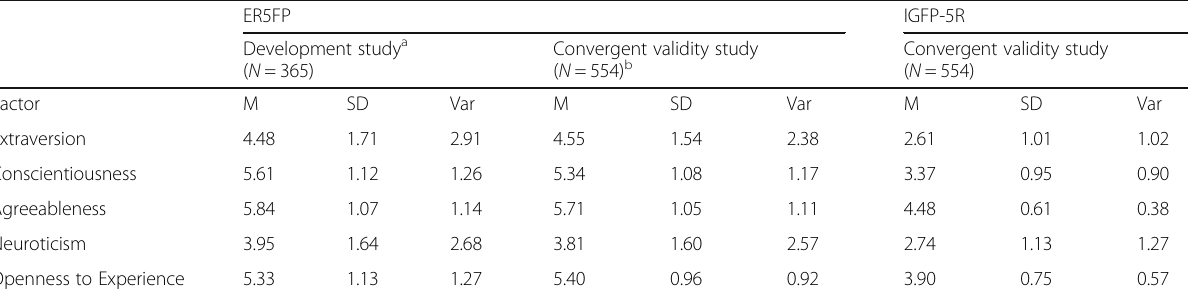
Table 5 Statistics of the factor scores of the scales ER5FP